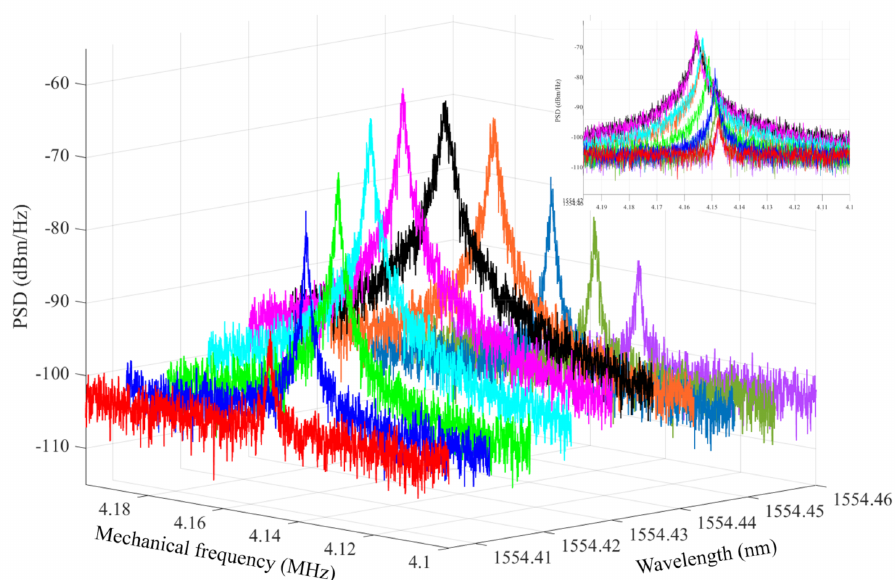
Figure 7. Mechanical spectra measurements with laser detuning in vacuum condition. The inset shows peak shape of the spectrum varies with laser